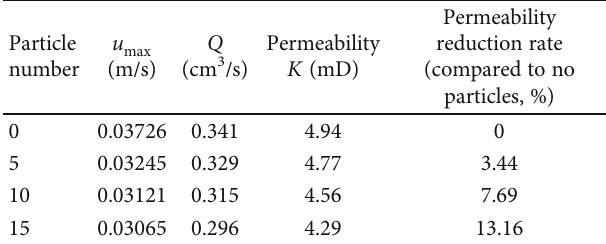
Figure 9: Flow contours with particles in a fractal fracture with varying particle Table 2: Cross-sectional fl ow and permeability for varying particle amounts.